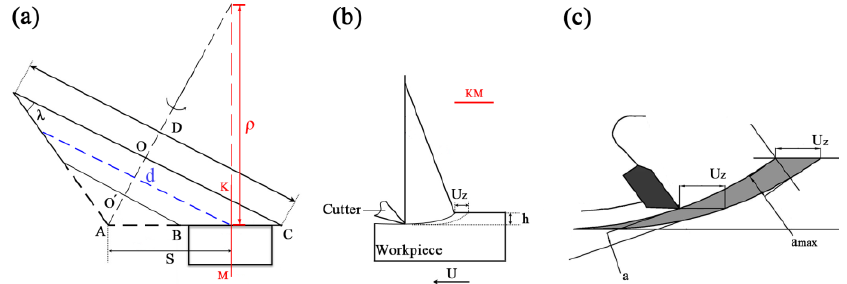
Figure 4. Motion analysis of the tapered milling: ( a ) taper milling, ( b ) cross-section KM of taper milling, ( c ) feed per tooth and chip thickness.